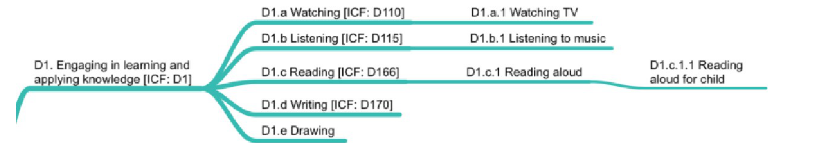
Fig 4. D1 domain on engaging in learning and applying knowledge.